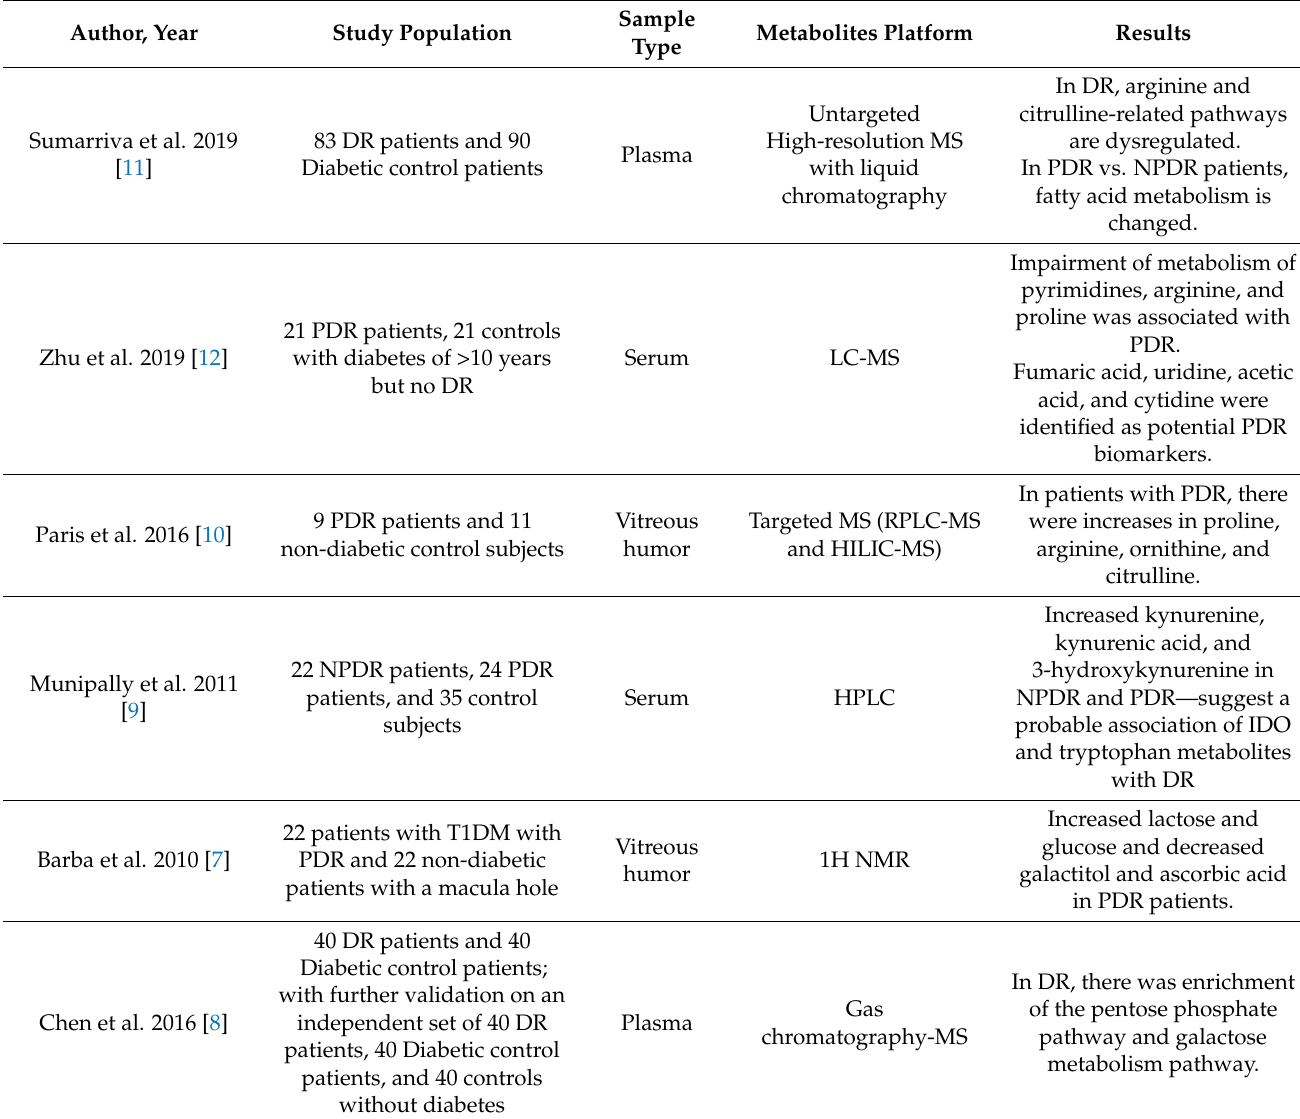
Table 3. Association between metabolites and DR in